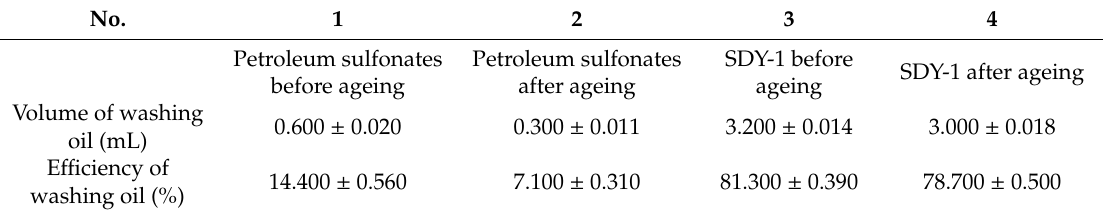
Figure 10. Efficiency of washing heavy crude oil before and after ageing for 3 d at 140 °C. ( 1 ) Petroleum sulfonates before ageing, ( 2 ) petroleum sulfonates after ageing, ( 3 ) SDY-1 before ageing and ( 4 ) SDY-1 after ageing. Table 2. Efficiency of washing oil before and after ageing for 3 d at 140 °C.